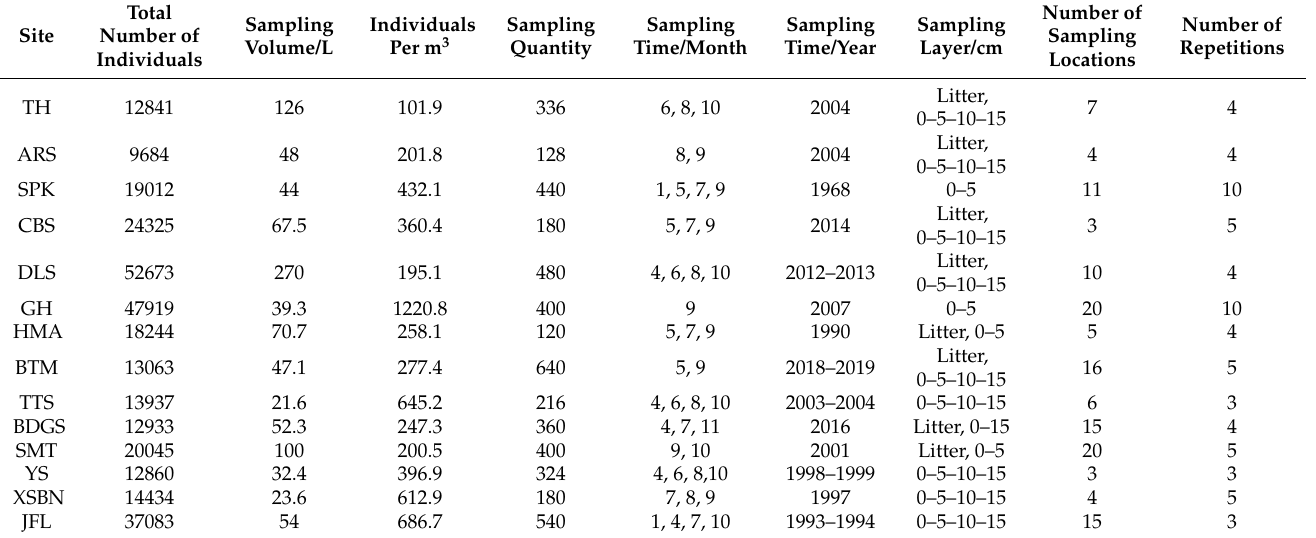
Table 2. The sampling details for 14 sites in East Asia, with TH = Tahe, ARS = Aershan, CBS = Chang- baishan, DLS = Donglingshan, BTM = Baotianman, BDGS = Badagongshan, TTS = Tiantongshan, SMT = Shimentai, JFL = Jianfengling, XSBN = Xishuangbanna, GH = Guanghua, SPK = Sapporo, HMA = Hiroshima and YS =